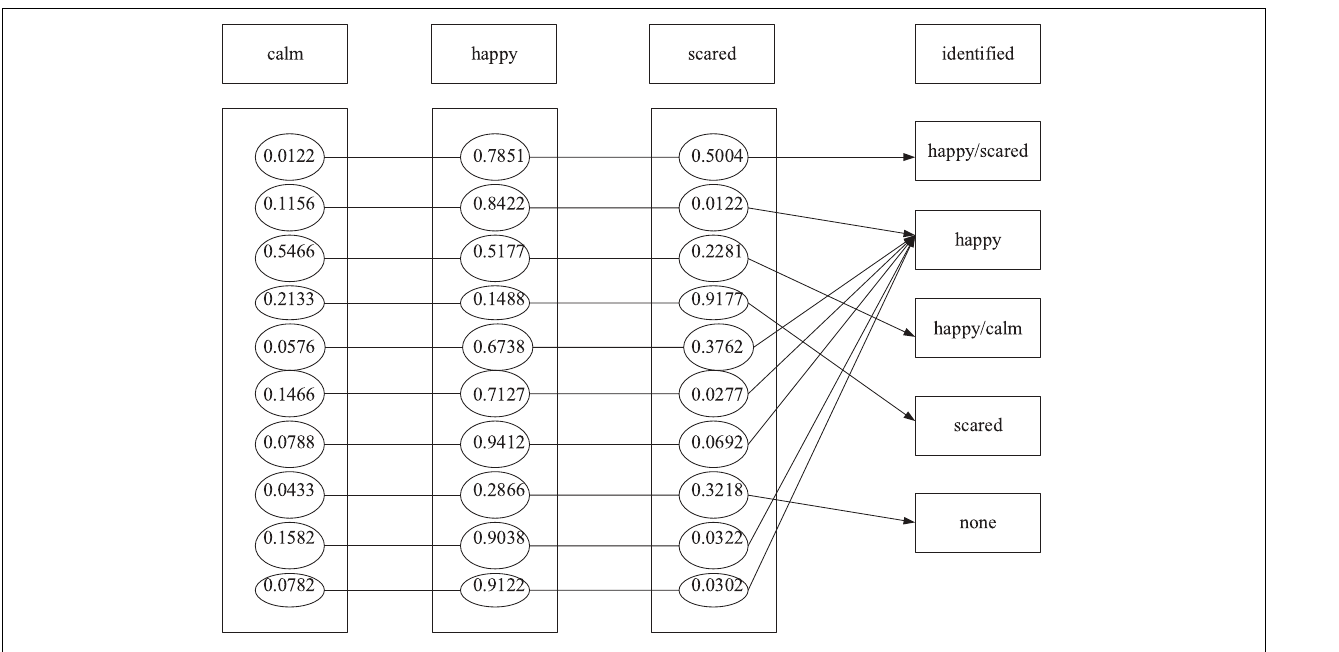
FIGURE 9 | Recognition results under the calm state.